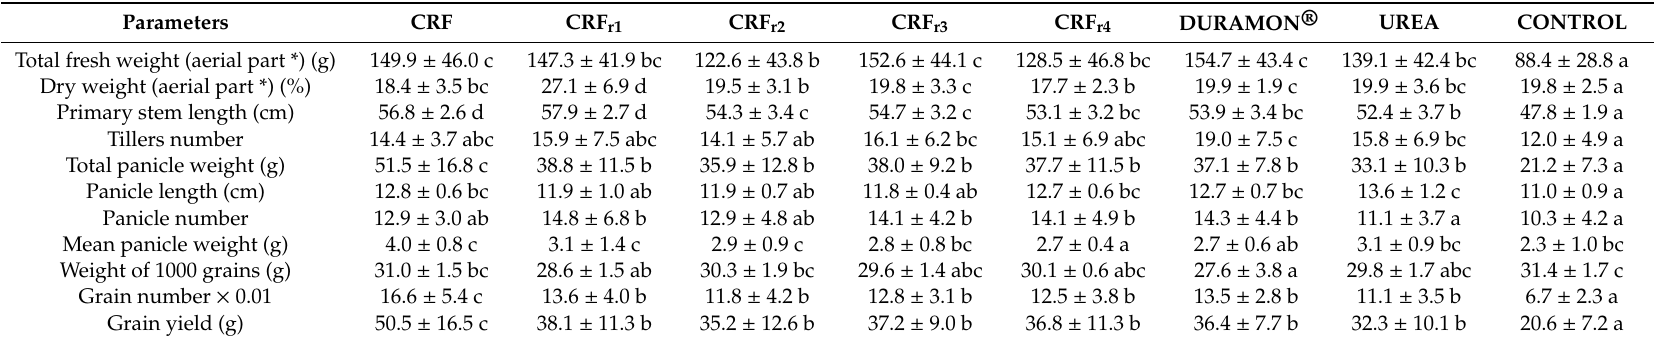
Di ff erent letters in the same row indicate significant statistical di ff erences (Tukey’s test, p < 0.05). * Total tillers without including